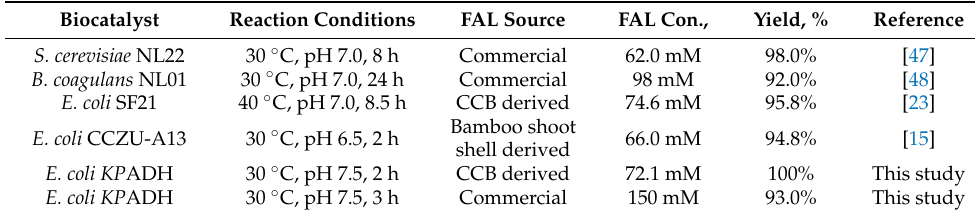
Figure 9. Mass balance for chemoenzymatic cascade transformation of milled CCB (75 g/L) into FLA in a tandem catalysis with UST-Sn-RH at 170 °C for 30 min and KP ADH cells at 30 °C and pH 7.0 for 2 h in an aqueous phase system. Table 2. Examples of transforming FAL into FOL with the